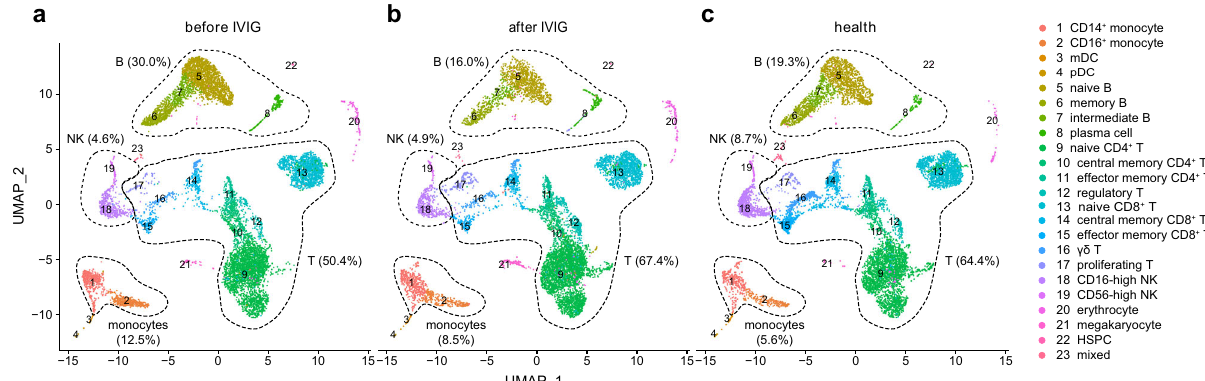
Fig. 1 Two-dimensional representation of cell types identi fi ed by scRNA-seq. The dimensional reduction is performed with the uniform manifold approximation and projection (UMAP). Each dot represents a cell, which is colored according to cell type. The cells are pooled across all patients and separated by conditions: a KD before intravenous immunoglobulin (IVIG) therapy; b KD after IVIG therapy; c healthy controls. Percentages of major cell types under each condition are shown on the plot, and percentages of subtypes are shown on Supplementary Fig. 3. mDC, myeloid dendritic cells; pDC, plasmacytoid dendritic cells; HSPC, hematopoietic stem and progenitor cells. Source data are provided in the Source Data